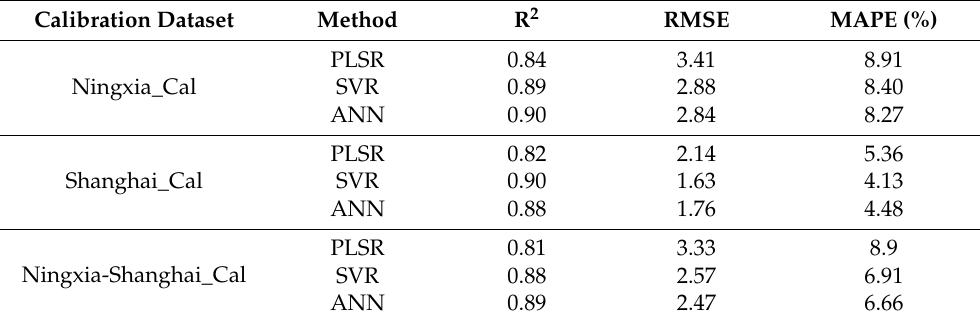
Table 5. Performance of rice LCC estimation models for Ningxia, Shanghai, and Ningxia-Shanghai combination calibration datasets based on all the eight vegetation